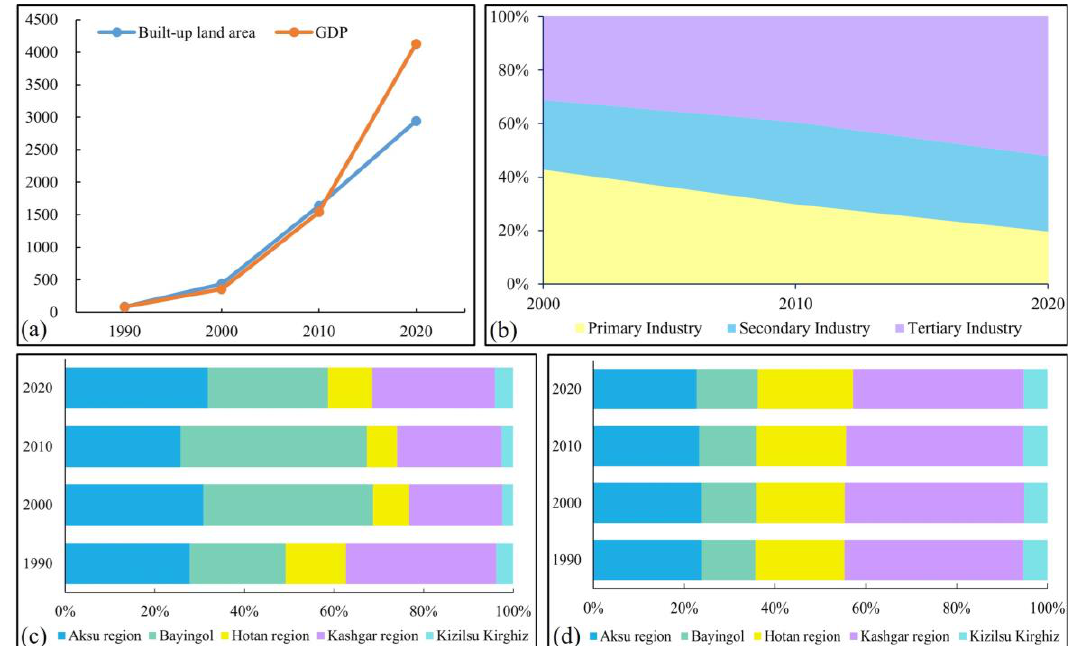
Figure 3. Changes in built-up land area and GDP in the Tarim River Basin from 1990 to 2020. ( a ): Trends in built-up land and GDP, ( b ): Industrial structure of the basin in each period, ( c ): Percentage of GDP in each region, and ( d ): Percentage of population in each region.